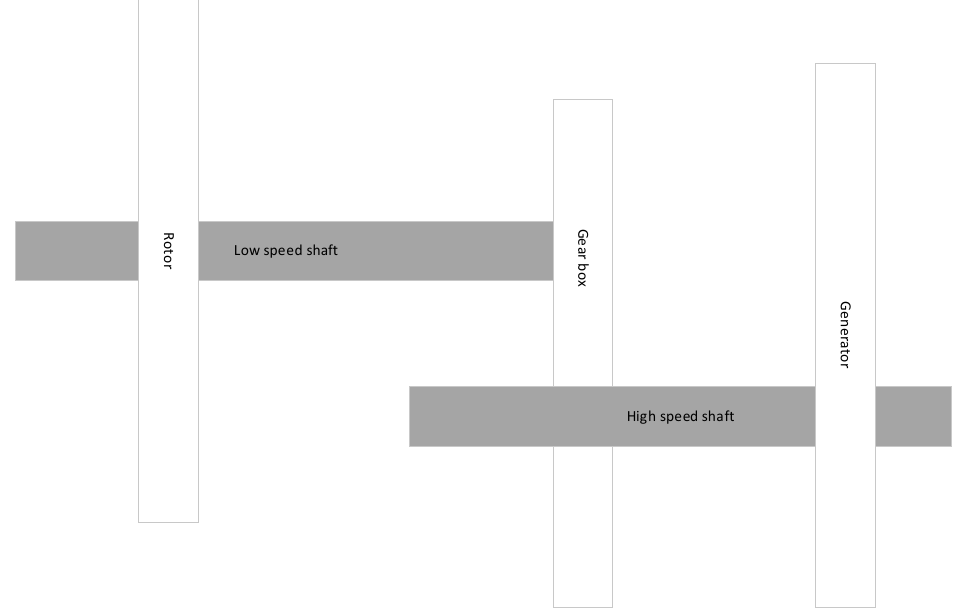
Figure 2. Schematic view of the drivetrain system.